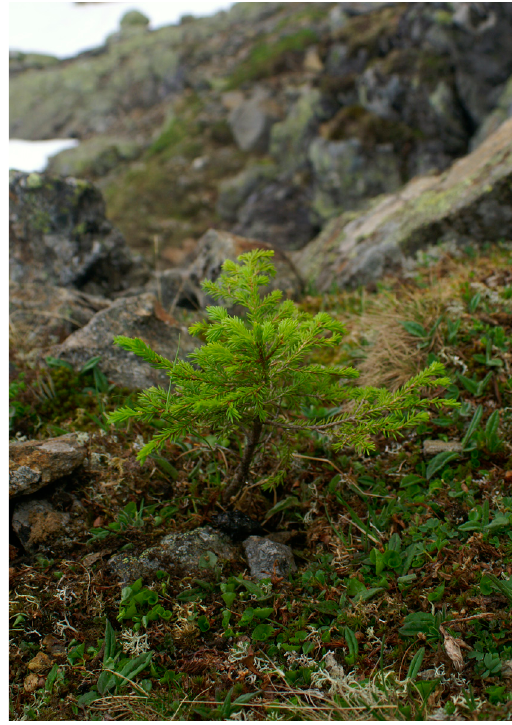
Figure 22: Young spruce sapling growing about 400 m high- er in elevation than the local treeline. Similar nearby indivi- duals have produced cones with some viable seeds (Kull- man 2002). Mt. Åreskutan, 1370 m a.s.l. 2 September 2006.